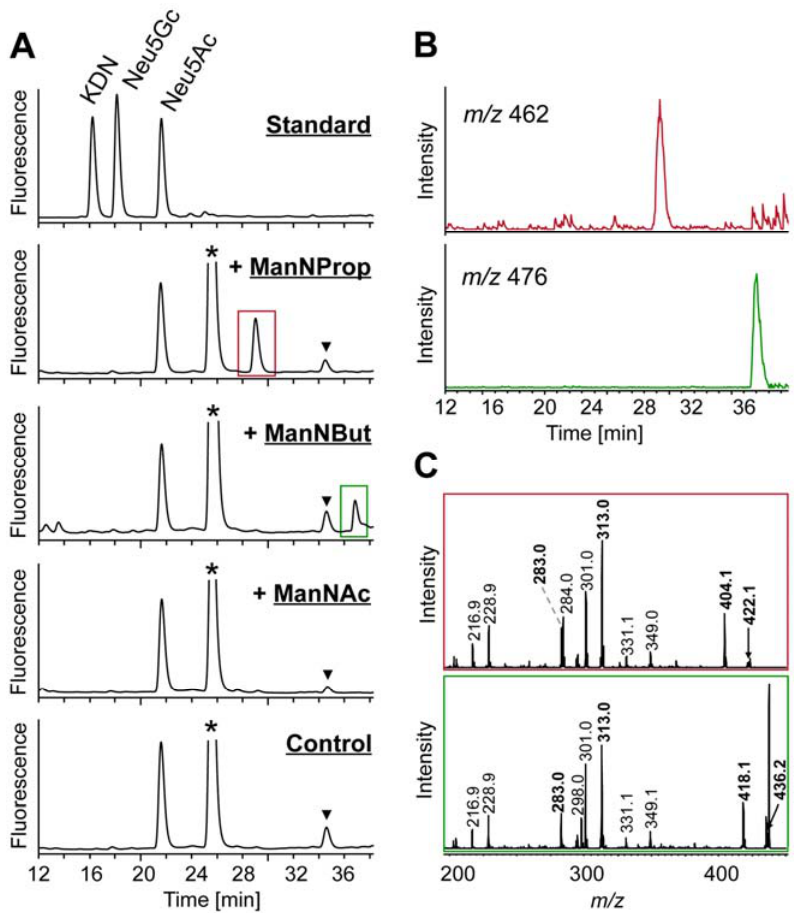
Figure 5. Analysis of sialic acid residues of glycoproteins isolated from HUVECs after incubation with per- O -acetylated ManNProp, ManNBut, and ManNAc. ( A ) Sialic acid residues obtained after DMB-labeling were separated by RP-HPLC. For control, HUVECs were not incubated with any sialic acid precursors. Peaks related to DMB reagent are labeled with an asterisk (*) and those related to unknown impurities are marked with a triangle ( ▼ ). ( B ) EIC of sodium adducts ([M+Na] + ) of Neu5Prop ( m/z 462) and Neu5But ( m/z 476) present in glycoproteins from HUVECs incubated with ManNProp and ManNBut, respectively. ( C ) ESI-MS/MS analyses of Neu5Prop (upper profile) and Neu5But (lower profile) registered as proton adducts ([M+H] + ). Annotation of fragment ions was carried out as defined in Figure